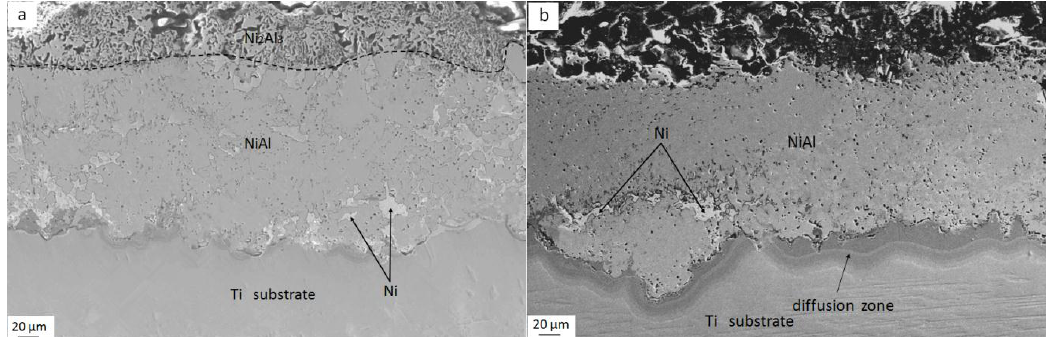
Figure 4. ( a ) Cross-sectional SEM image of Al/Ni coating after testing for 10 h at 1073 K; ( b ) Cross-sectional SEM image of Al/Ni coating after testing for 10 h at 1173 K.